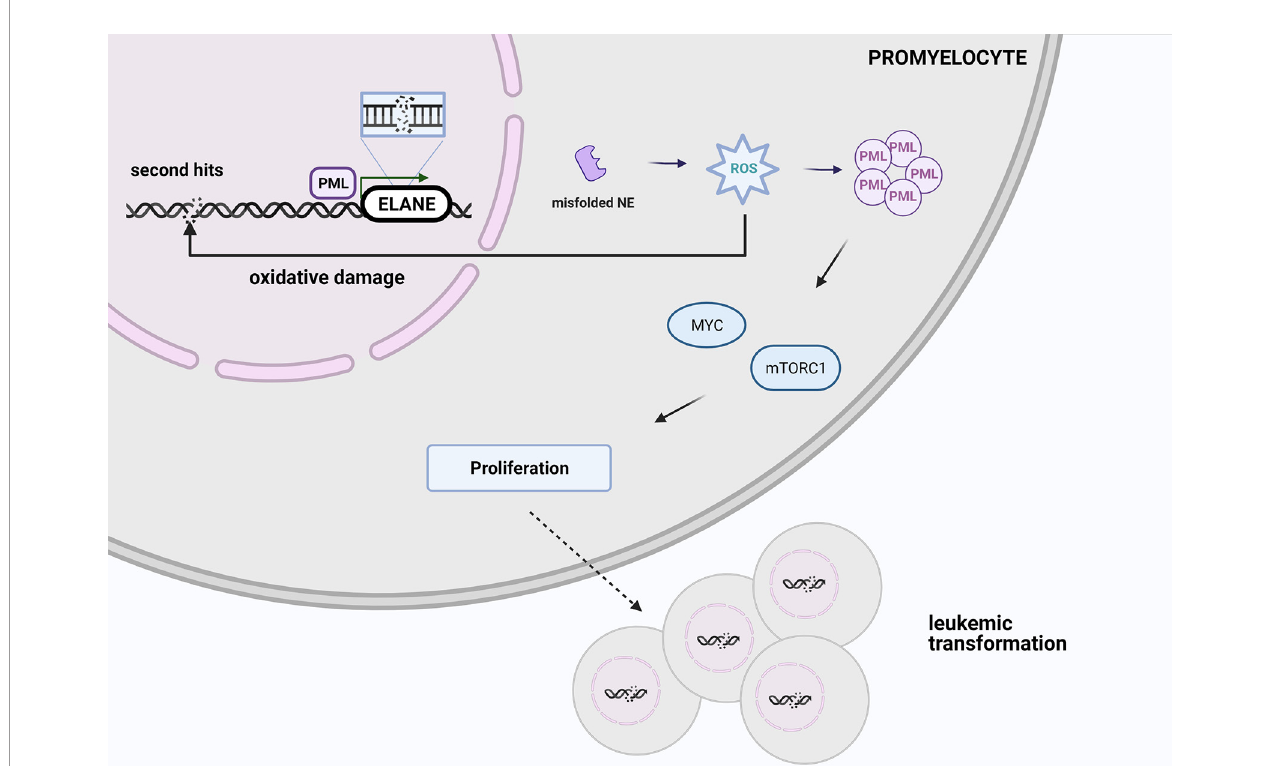
FIGURE 3 | At the stage of promyelocyte the increased ROS level triggered by misfolded elastase leads to oxidative damage, which may be responsible for 2 nd hits and initiate malignant transformation. PML-NBs via MYC and mTOR signaling promotes malignant cell proliferation. Created with